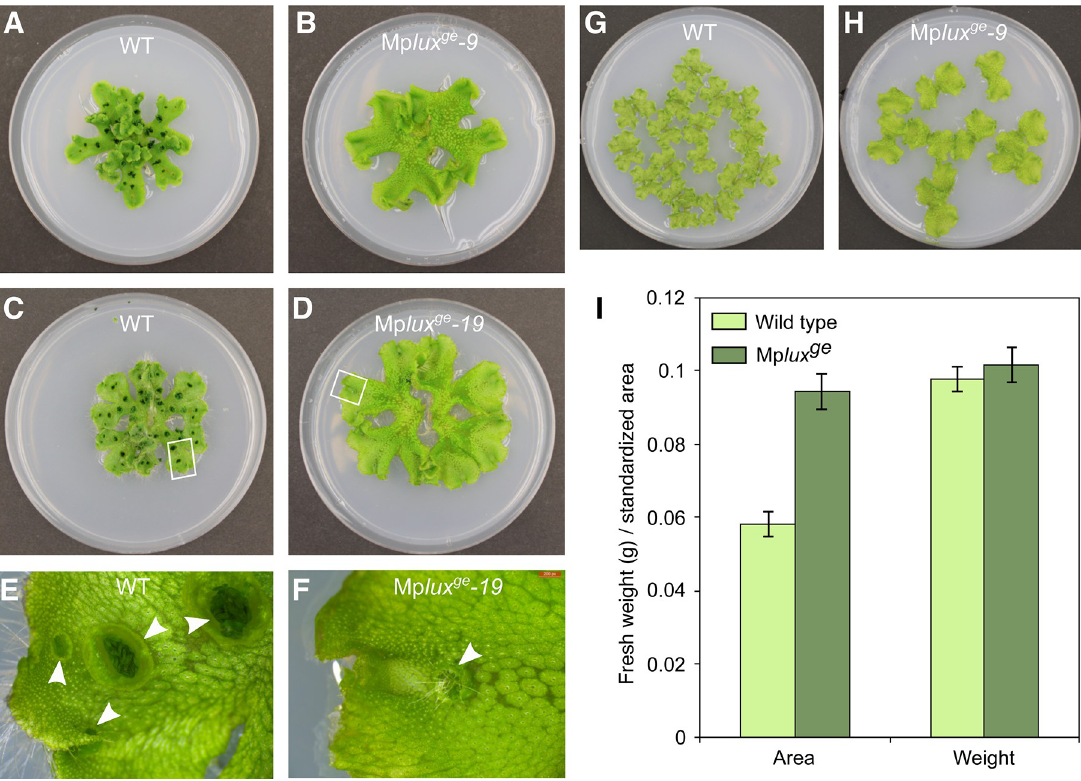
Fig 2. Marchantia polymorpha lux ge knock-out mutants show increased growth, reduced gemma cup formation and reduced gemma dormancy. (A) 6-week-old wild-type plant grown in LD on standard growth medium (same plant as in Fig 1B). (B) 6-week-old Mp lux ge -9 plant grown in LD on standard growth medium. (C) 6-week-old wild-type (Upp14) plant grown in LD on medium supplemented with 2% sucrose. (D) 6-week-old Mpl ux ge -19 plant grown in LD on medium supplemented with 2% sucrose. (E) Close-up of boxed area in (C), showing gemma cups with dormant gemmae. (F) Close-up of boxed area in (D), showing a single gemma cup with protruding rhizoids indicating germinating gemmae. (G,H) 3-week-old gemmalings grown in LD on standard growth medium, used to produce data shown in (I). For these measurements we used Upp13 (G) and 14, and Mp lux ge -9 (H) and 19 . (I) Measurements of area and weight of wild type and Mp lux ge . Mean area and weight (n = 16 for Upp; n = 14 for Mp lux ge ) is given ± SE. Two-tailed t-test for area and weight P = 4 x 10 − 11 and P = 0.5, respectively. Petri dishes are 9 cm